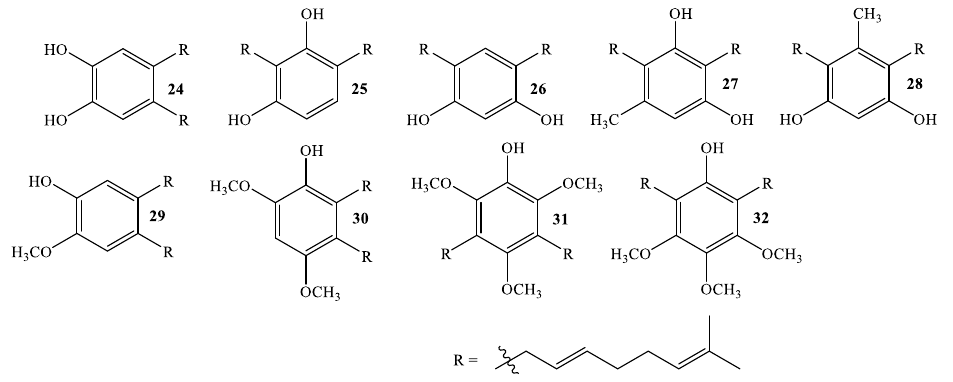
Figure 3. Structure of new ( 24 – 26 , 29 and 32 ) and other structurally related linear di-geranylated phenols/methoxyphenols (Group III).